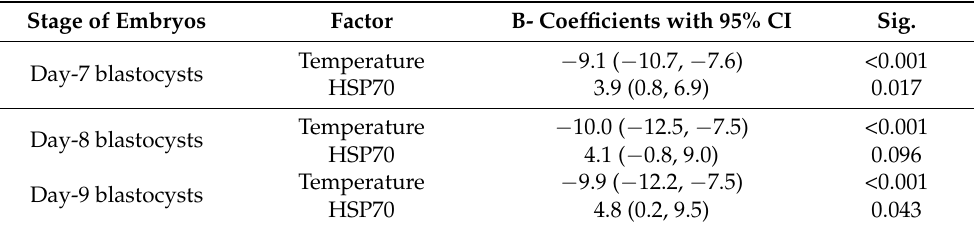
Table 2. Effects of Temperature during in vitro culture and HSP70 addition in the IMC medium on blastocyst formation rates on days 7, 8 and 9.